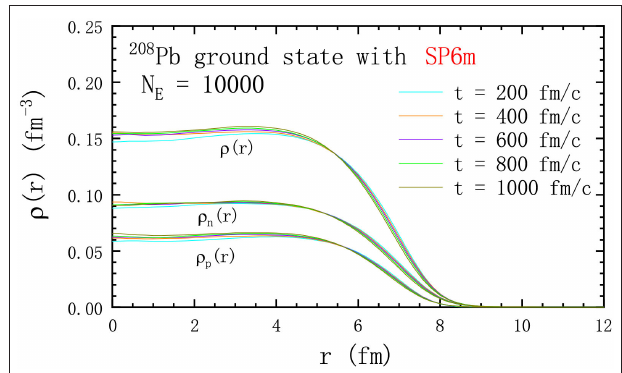
FIGURE 2 | Time evolution of the radial density profile of the ground state of 208 Pb based on the LHV calculation (i.e., the LBUU calculation without NN scatterings) with the N3LO Skyrme pseudopotential SP6m up to 1,000 fm / c . Reproduced from reference [61] with permission from the American Physical